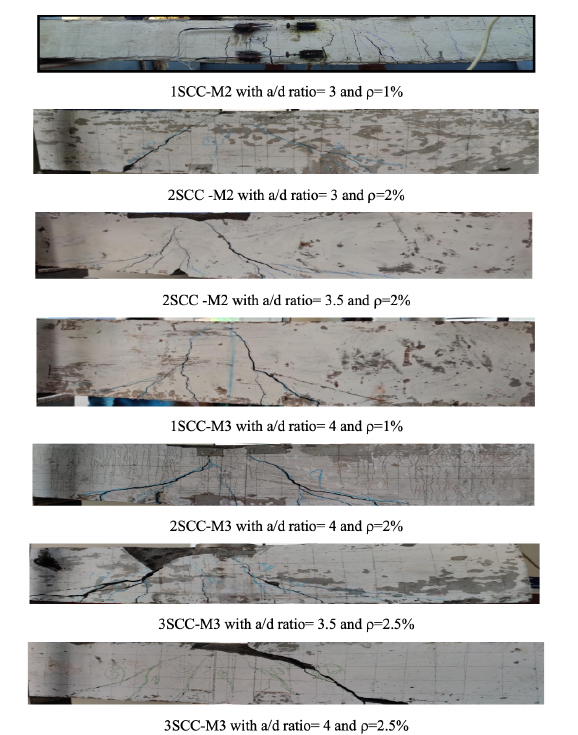
Fig. 2. Failure mode of